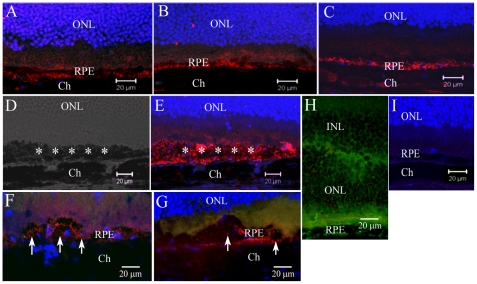
C3d and C5b-9 deposition at the retina/choroidal interface of different strains of mice.Cryosections of eyes from 22–24-month old mice were stained for C3d (red) or C5b-9 (green in F and G) and observed by confocal microscopy. A, an image from a 22-momth old WT mouse. B, an image from a 22-momth old CCR2 KO mouse. C, an image from a 22-momth old CCL2 KO mouse. D and E, images taken from a 24-momth old CCL2 KO mouse showing area of RPE cell death (asterisks) and extensive C3d deposition (red). F and G, images taken from a 24-momth old CCR2 KO mouse (F) and a 24-month old CCL2 KO mouse showing areas of RPE cell death (arrows) with C3d deposition (red), but no C5b-9 deposition (green). H, a retina from a mouse with EAU [25], [35] was used as positive control for C5b-9 staining (green). I, Isotype control antibody staining for C3d in a 24-month CCL2 KO mouse showing no background staining. ONL, outer nuclear layer. RPE, retinal pigment epithelia. Ch, choroid.